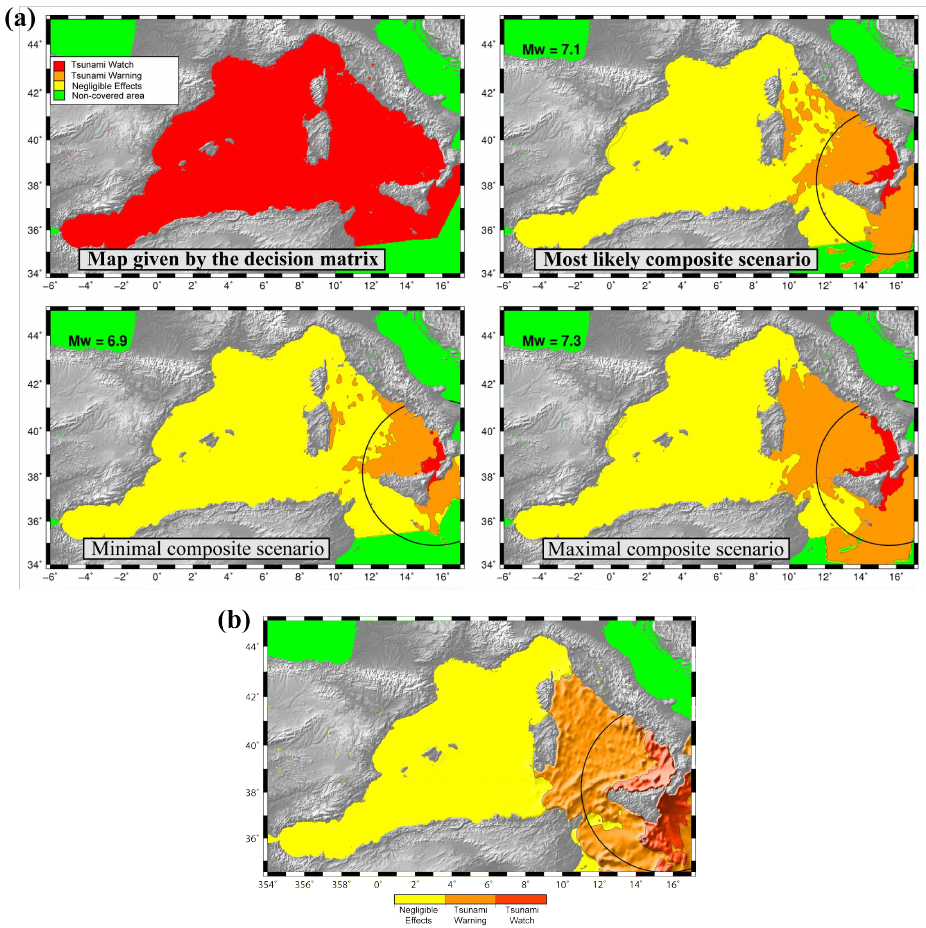
Fig. 11. (a) Result of the composite scenarios calculation process (i.e., model-based tsunami prediction system): final representation destined for the French authorities using the test case of the 1908 Messina earthquake ( M s = 7 . 1, Sicily). Black circle: 400km radius area around the epicenter (decision matrix parameter). (b) Warning map resulting from “on the fly” tsunami modeling (source parameters of Tinti et al.,